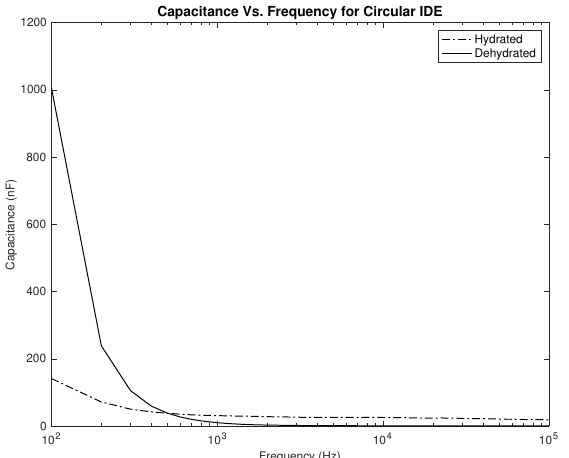
Figure 8. Simulation results—capacitance (nF) of hydrated and dehydrated skin using the rectangular IDE design.